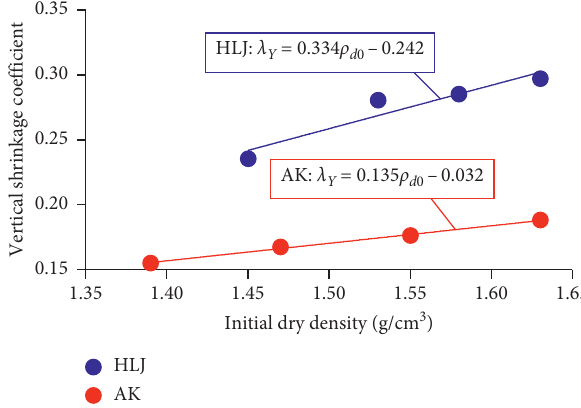
Figure 4: The relationships between vertical shrinkage coefficient and the initial dry